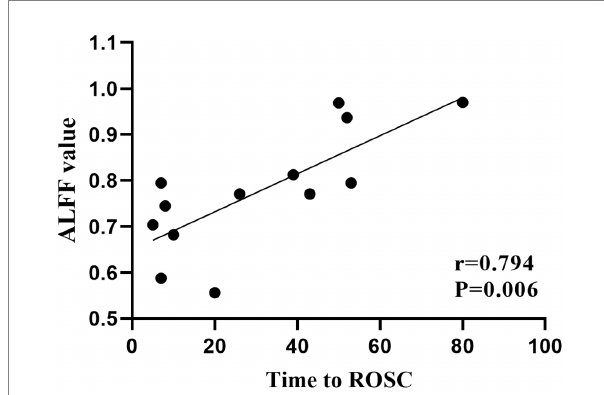
FIGURE 3 Significant correlations between clinical characteristics and ALFF values in patients with cardiac arrest. Mean ALFF values in the left hippocampus and parahippocampal gyrus were positively correlated with time to ROSC. ALFF, amplitude of low frequency; ROSC, return of spontaneous